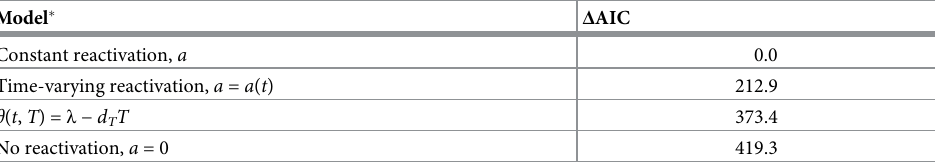
Table 2. Model comparisons. AIC values ( Δ AIC) are quoted relative to the minimum AIC value across all models. The model with Δ AIC = 0 is the model with lowest AIC and thus has most statistical support. See Table 1 for parameter